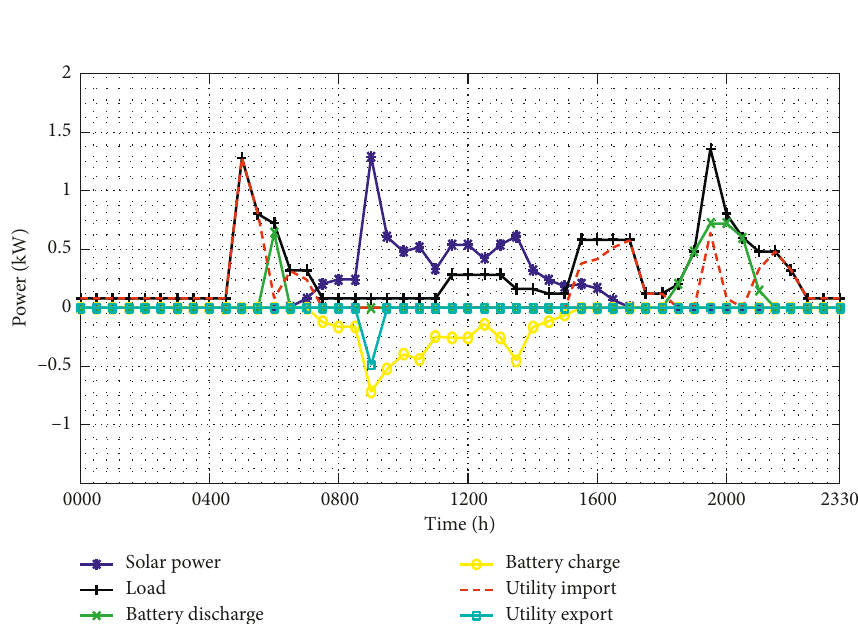
Figure 10: Power source operation of the system with battery local SoC limits for case 6.